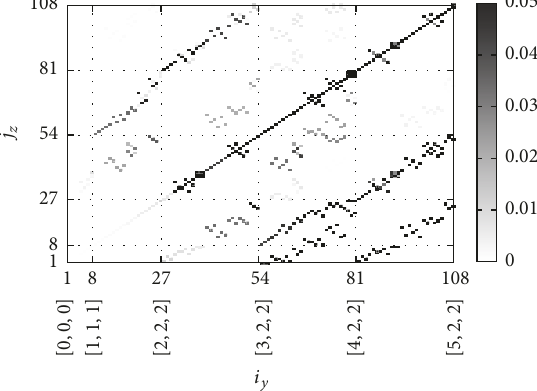
Figure 7: Cuboid eigenvalues (3rd order, 𝑁 = 1 ).